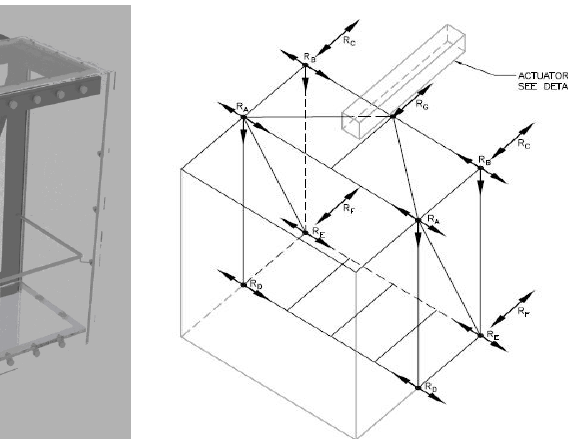
Figure 5: Glass Observation Box Framing support points.